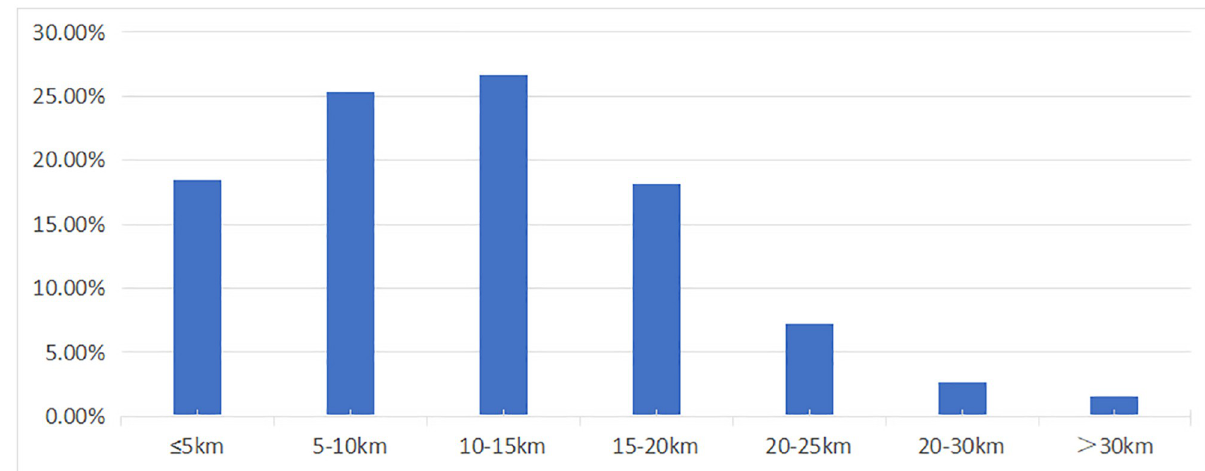
Fig 8. Distribution of distance cost of fever clinics for demand points.